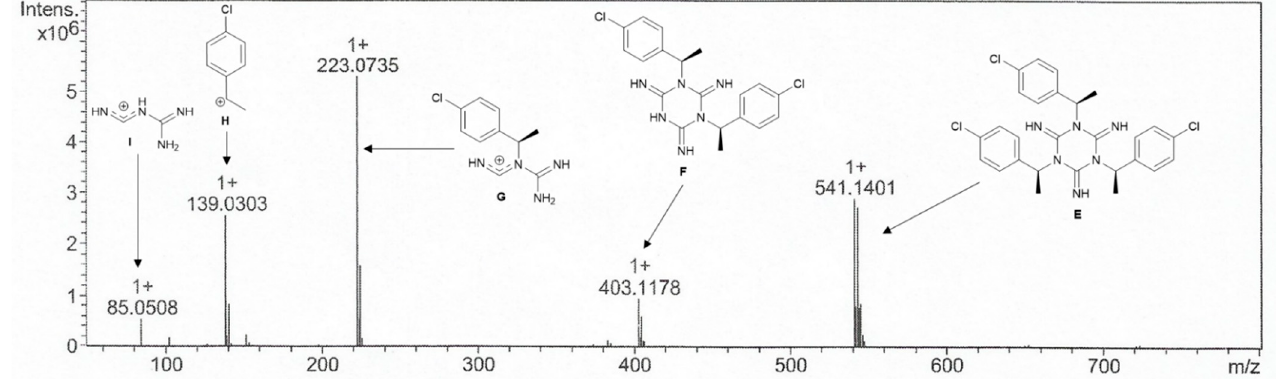
Figure 2. HRMS (ESI) obtained for N -[(1 R )-1-(4-chlorophenyl)ethyl]-cyanamide 2 .